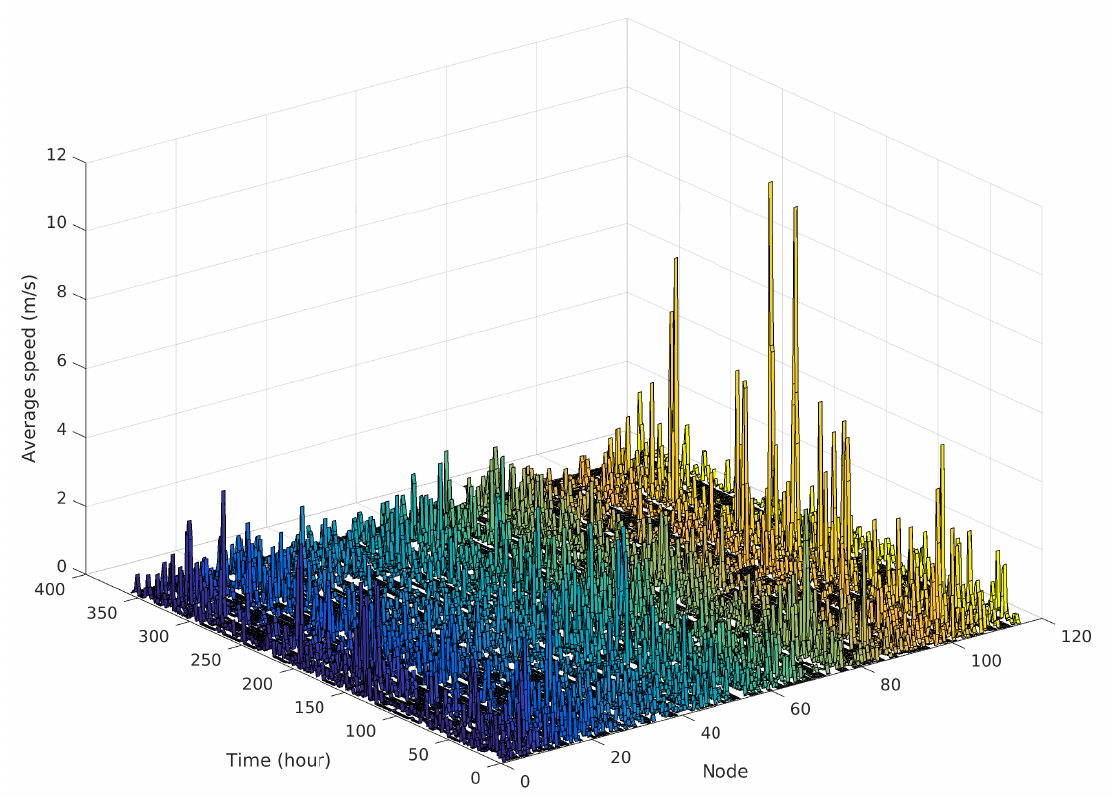
Figure 6. Average node speed at each hour of the movement